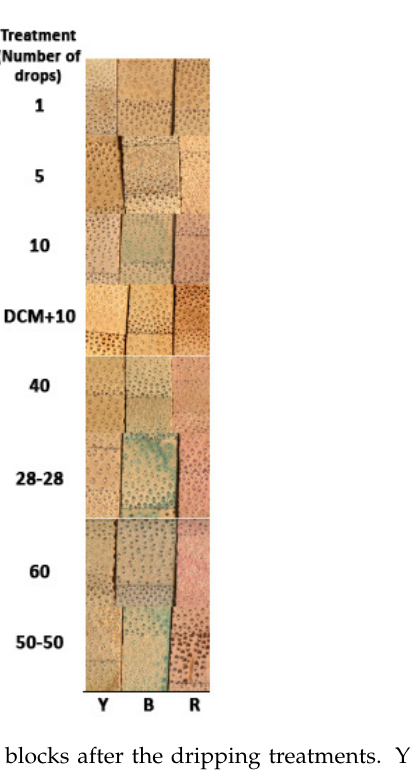
Figure 4. External face of the bamboo blocks after the dripping treatments. Y = yellow pigment; B = blue pigment; and R = red pigment; DCM: dichloromethane.